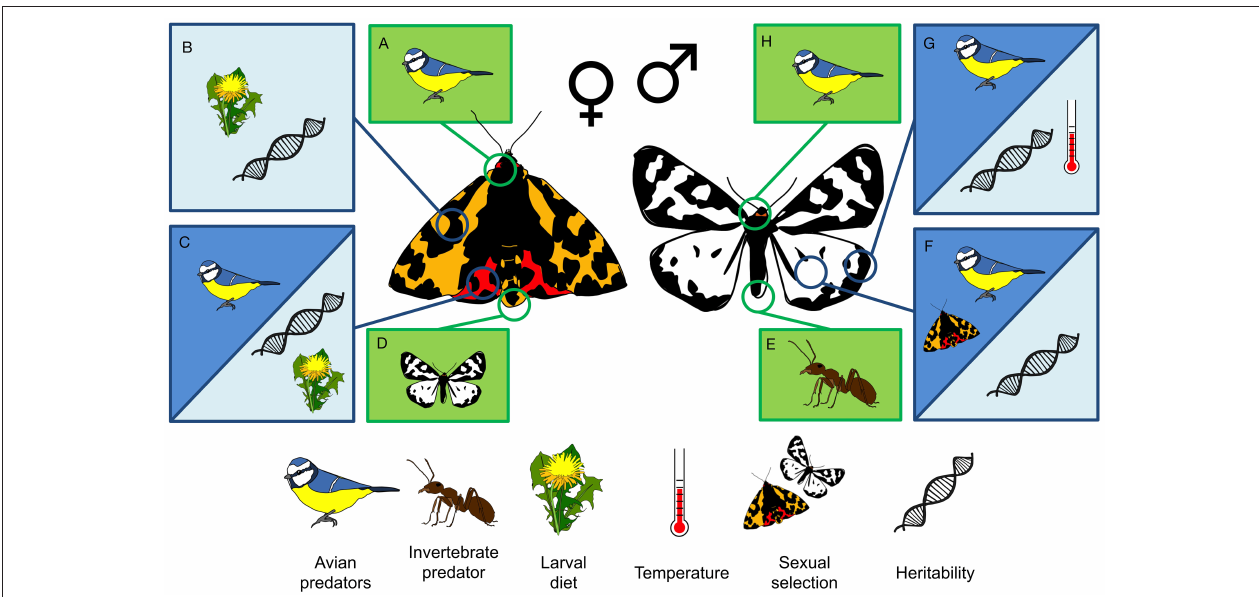
FIGURE 9 | A schematic illustration of the different selective (dark) and environmental (light) factors currently known to be acting on chemical (green) and visual (blue) signals in the wood tiger moth. Anti-clockwise from top left: (A) Female neck defensive fluids are deterrent to avian predators; (B) Female melanisation is heritable and influenced by larval diet; (C) Female hindwing coloration is highly heritable, affected by larval diet, and influences avian predation risk; (D) Males follow female pheromone trails; (E) Male abdominal defensive fluids deter invertebrate predators; (F) Male hindwing colouration is heritable and plays a role in both predator deterrence and male mating success; (G) Male melanisation is heritable and influences both thermoregulation and predation risk; (H) Male neck defensive fluids are deterrent to avian predators. See text for details.